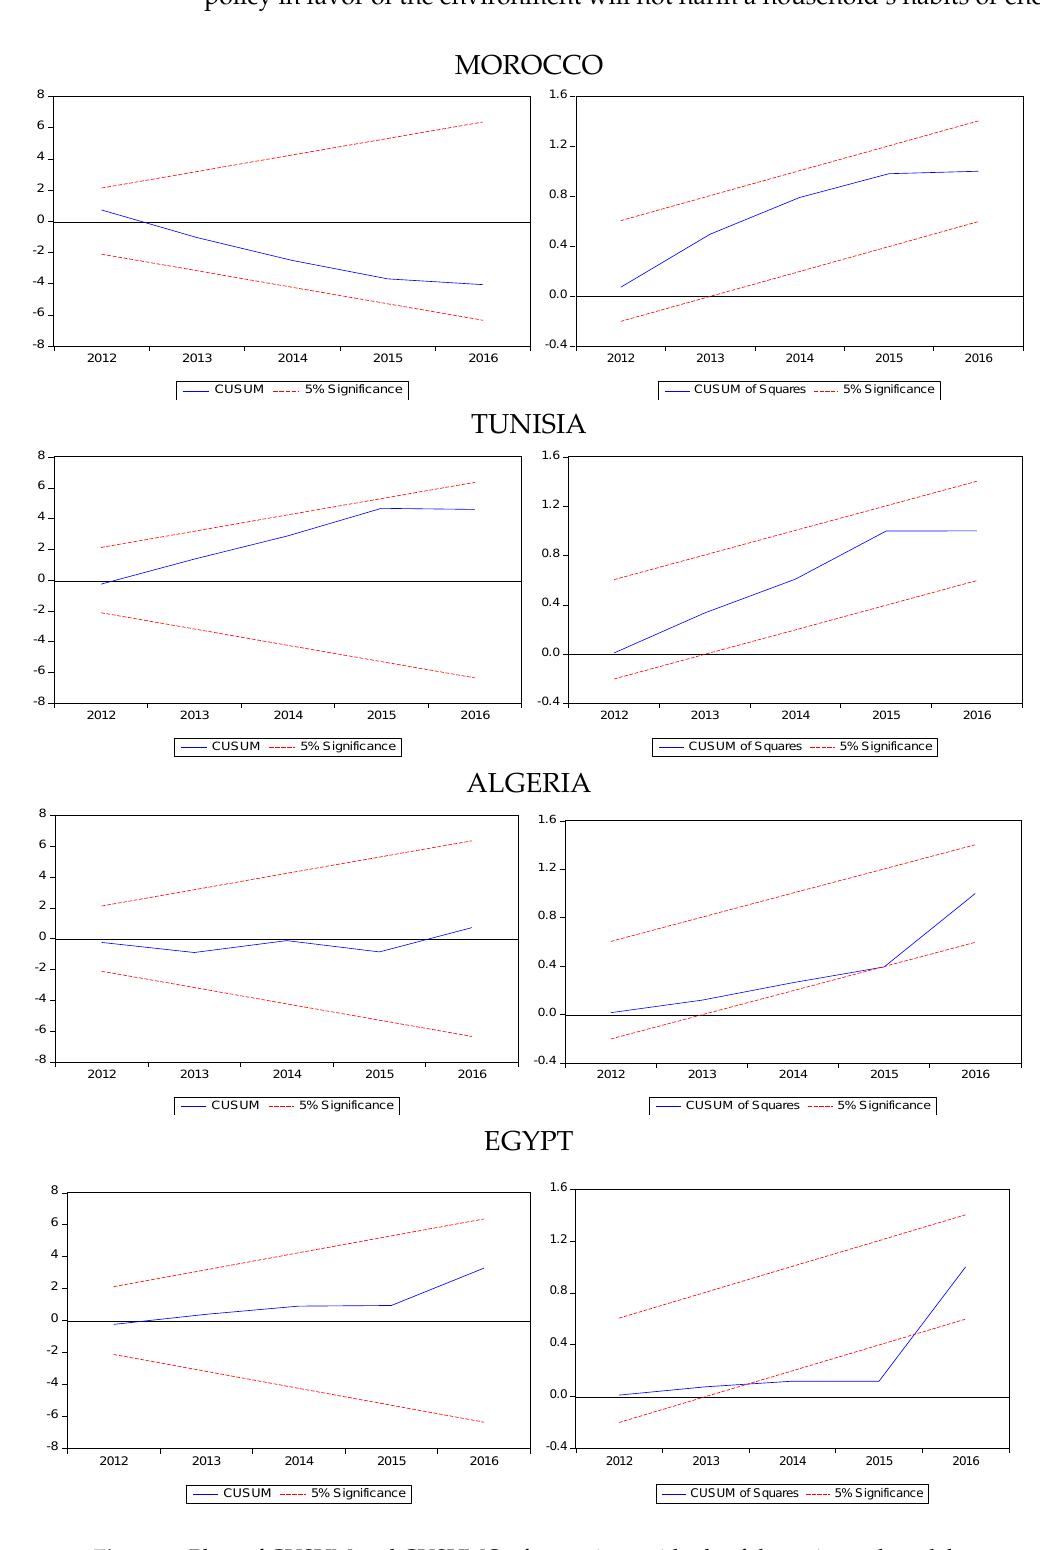
Figure 3. Plots of CUSUM and CUSUMQ of recursive residuals of the estimated models.